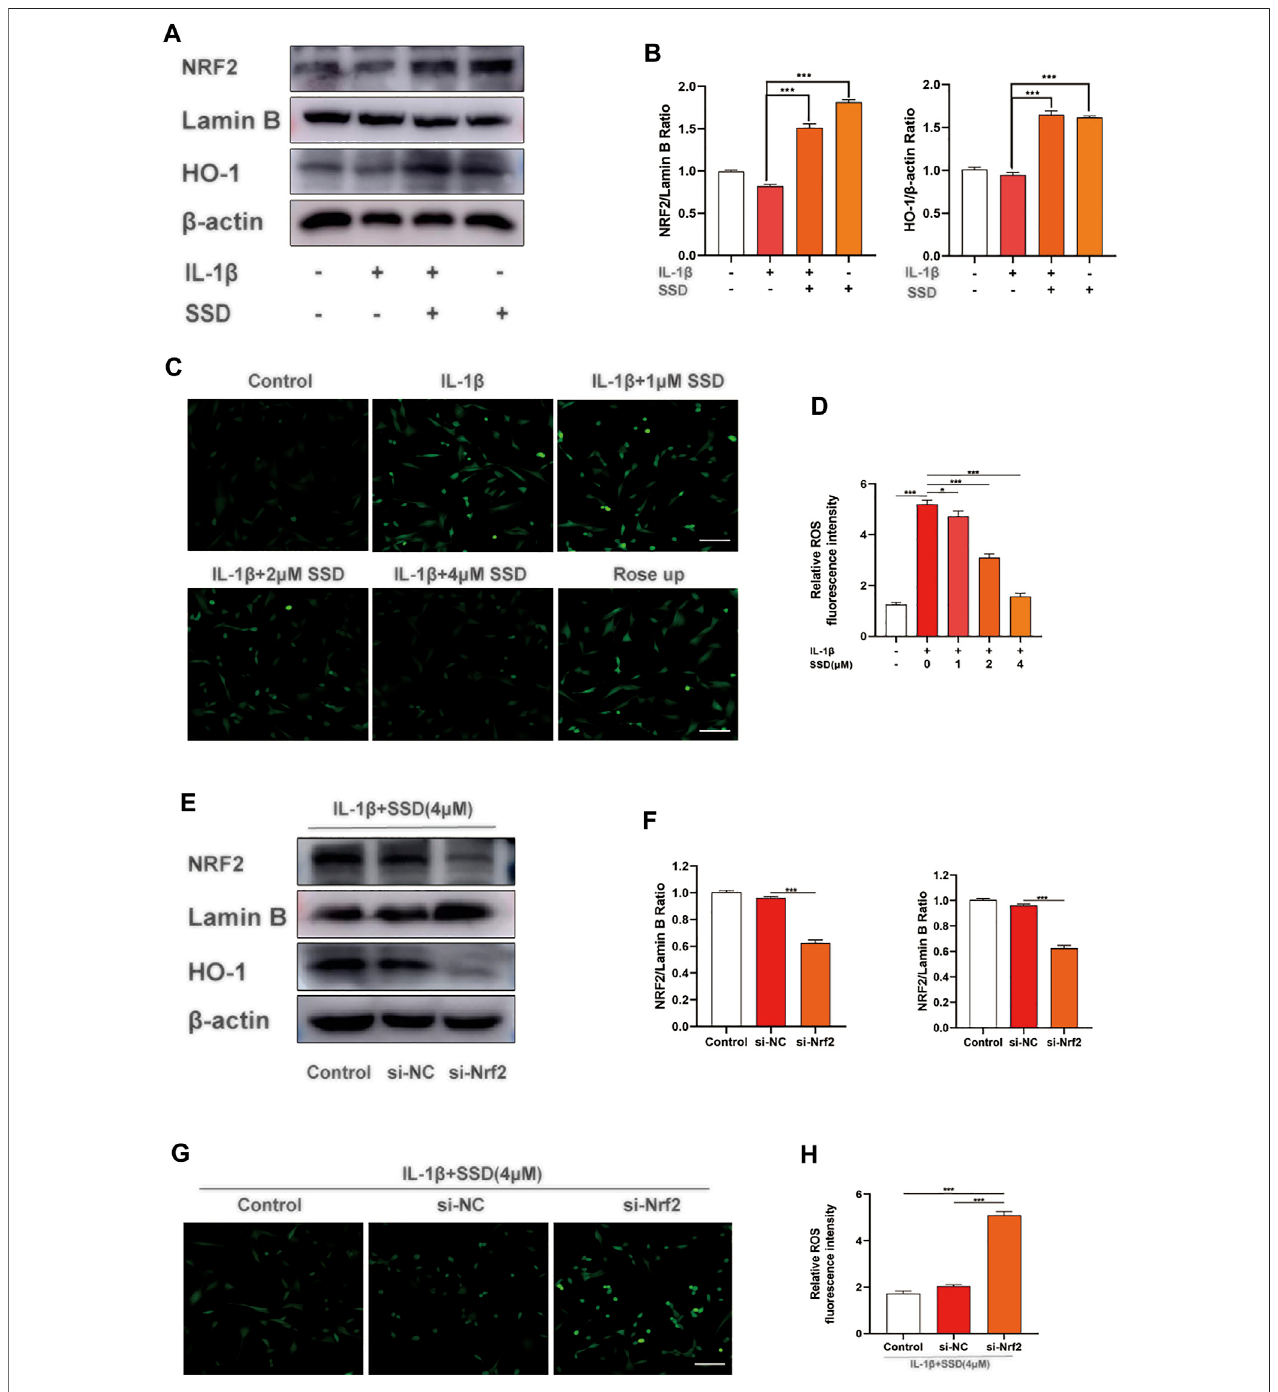
FIGURE 5 | SSD activated the Nrf2/HO-1 pathway and suppressed the generation of ROS. (A) SSD increased the expression levels of Nrf2 and HO- 1regardless of the existence of IL-1 β stimulation. (B) The quanti fi cation of Nrf2 and HO-1 protein expression levels. (C) Immuno fl uorescence was conducted to visualize ROS level. SSD decreased cellular ROS immuno fl uorescence intensity under IL-1 β stimulation. (D) The quanti fi cation of ROS immuno fl uorescence intensity. (E) SSD could not increase the expression level of HO-1 after Nrf2 was knocked out. (F) The quanti fi cation of Nrf2 and HO-1 protein expression levels. (G) SSD has no effects on cellular ROS level under IL-1 β stimulation after Nrf2 was knocked out. (H) The quanti fi cation of immuno fl uorescence intensity (original magni fi cation, ×200; scale, 15 μ m). Mean ± SD was applied with all data. The experiments in vitro were performed independently at least 3 times. *** p < 0.001, ** p < 0.01, * p < 0.05.